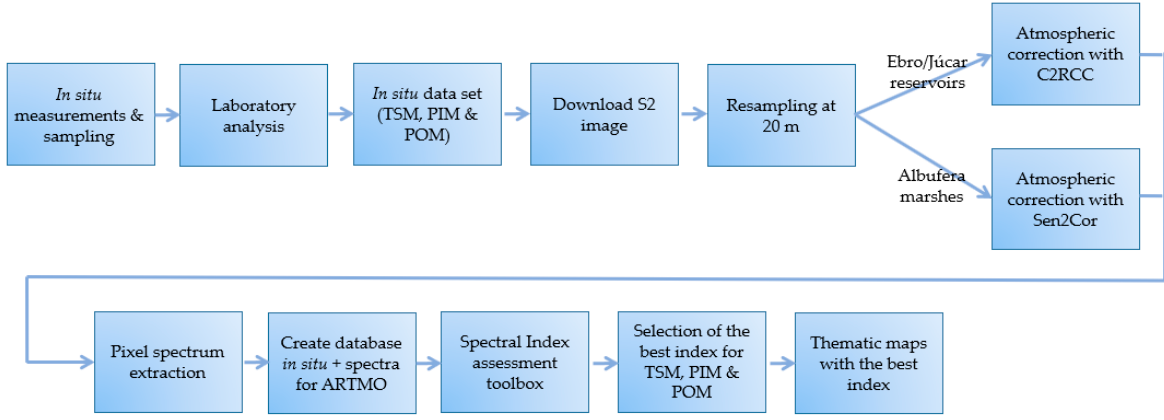
Figure 4. Algorithms developing flowchart.